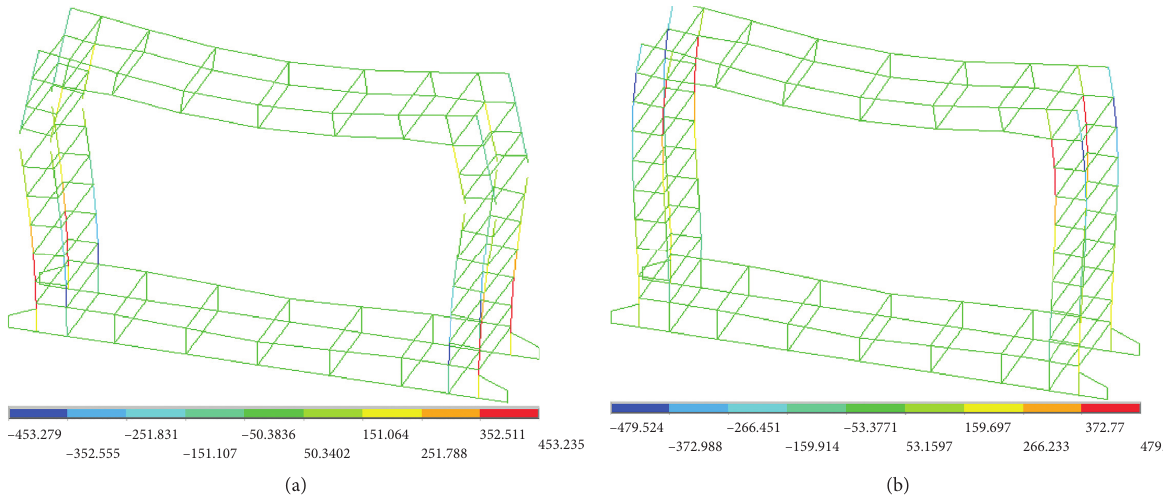
Figure 13: Axial force diagrams of BC reinforcement in the Y -direction. (a) Round hinged BC. (b) Integral BC.